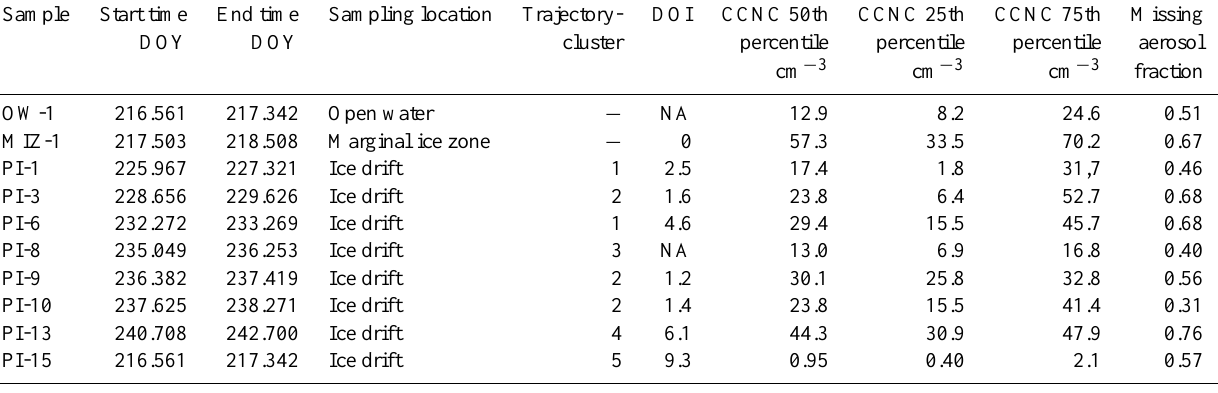
Table 2. The 25th, 50th (median) and 75th percentile CCNC separately for open water (OW-1), marginal ice zone (MIZ-1) and pack ice (PI-1, 3, 6, 8, 9, 10, 13, and 15) measurements at 0.2% SS (counter 1). Values are at STP. Also listed are information on sampling start–stop times and sample duration and on the air trajectory cluster and average DOI during the sampling time for each of the impactors. Sample